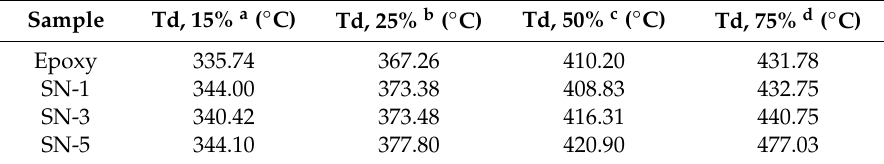
loss; d Temperature at 75% weight loss.